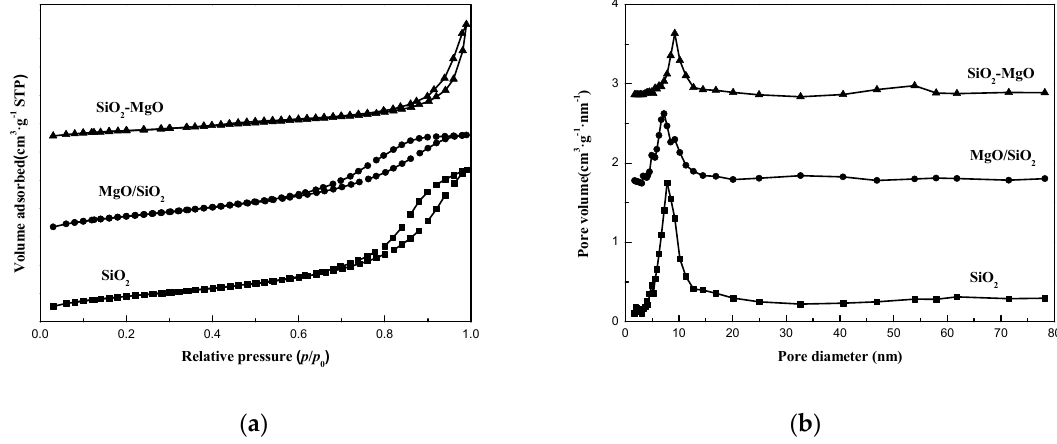
Figure 1. XRD patterns of the supports.